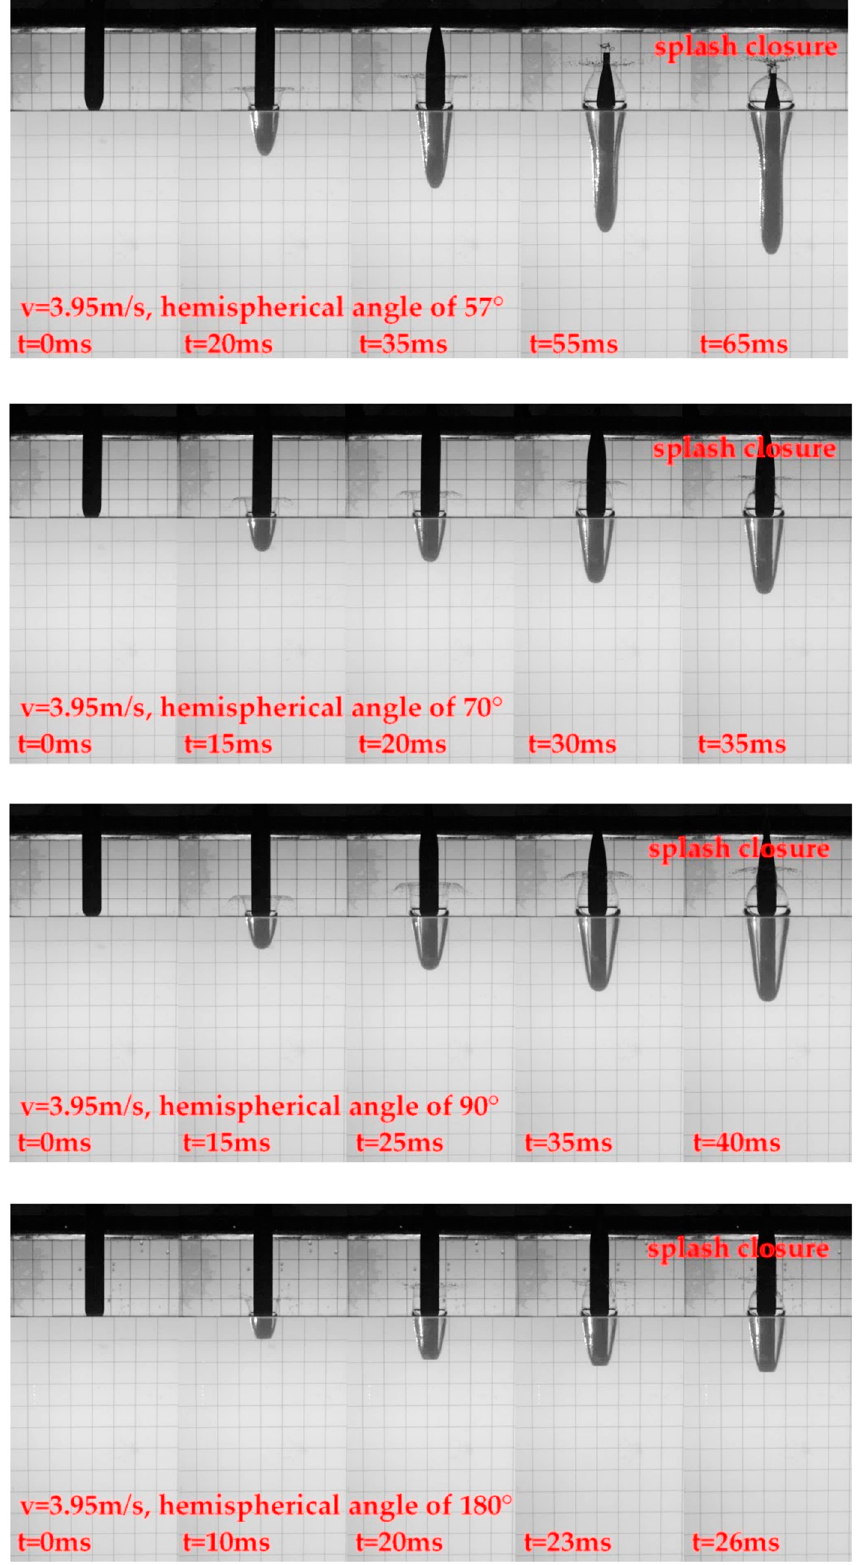
Figure 16. Experimental diagram of the hydrophobic model water entry at a speed of 3.95 m/s.